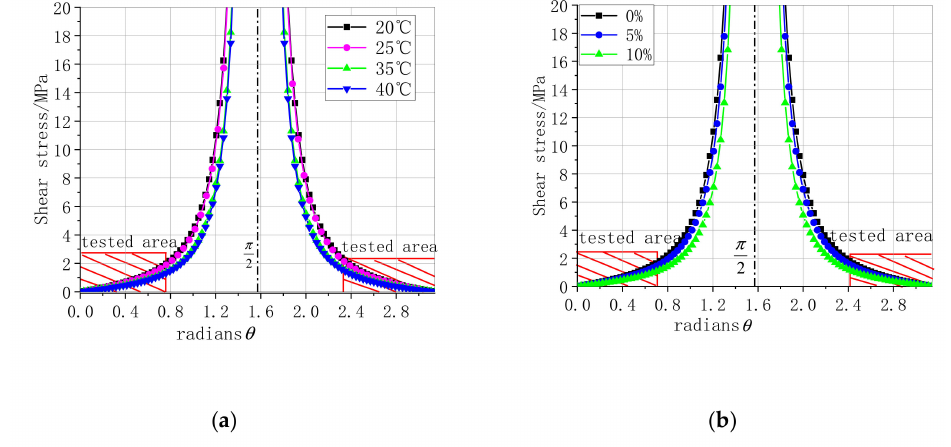
Figure 10. RelationshipofshearstressandslopeunderdifferentvaluesofTandhumidity. ( a )Relationship between T and θ , ( b ) relationship between humidity and θ .